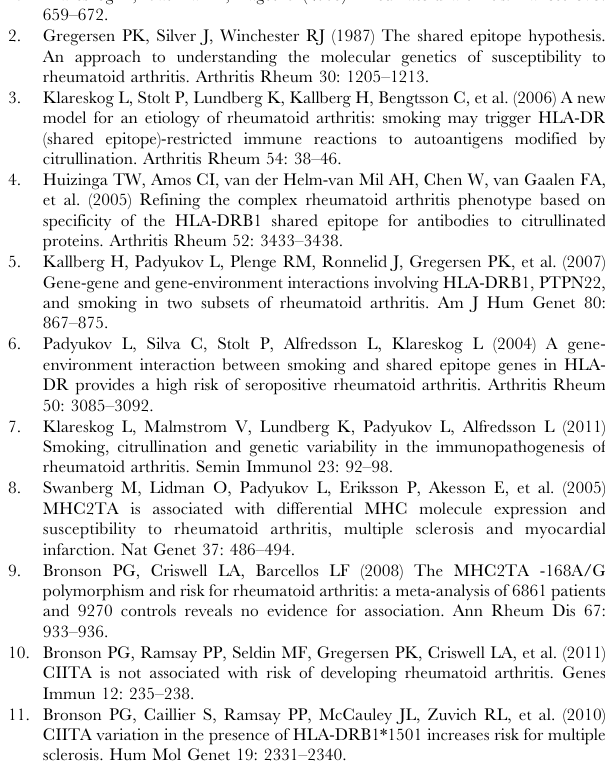
Table S5 Additive interaction between rs3087456 and HLA-DRB1 SE subgroups. # Exclusion of individuals